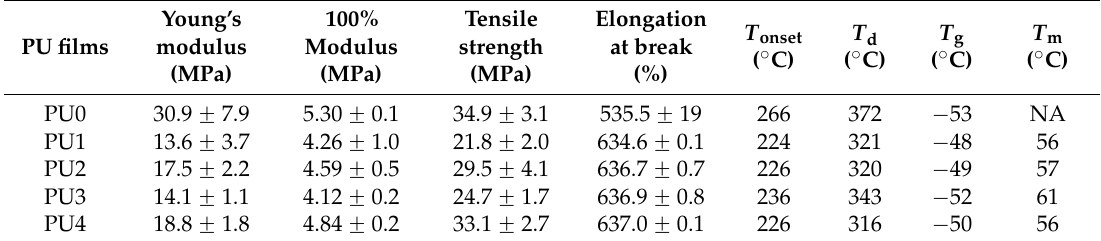
Table 3. The mechanical, thermal properties of PU films.